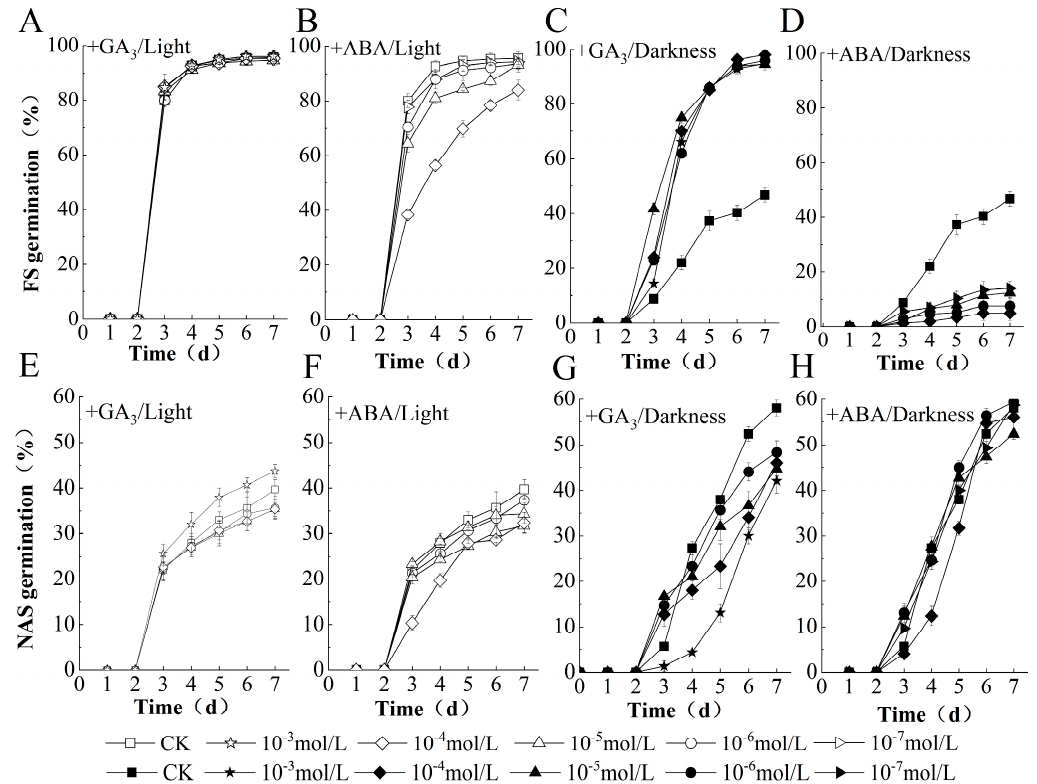
Figure 2. ABA and GA sensitivity of FS and NAS during germination. Percentage of germination on FS seeds ( A – D ) and NAS ( E – H ) kept in darkness or under 12 h light/dark cycle and 325 µ mol m − 2 s − 1 white light condition, and (+) indicates that the gradient concentration of gibberellin or abscisic acid is used for seed treatment.